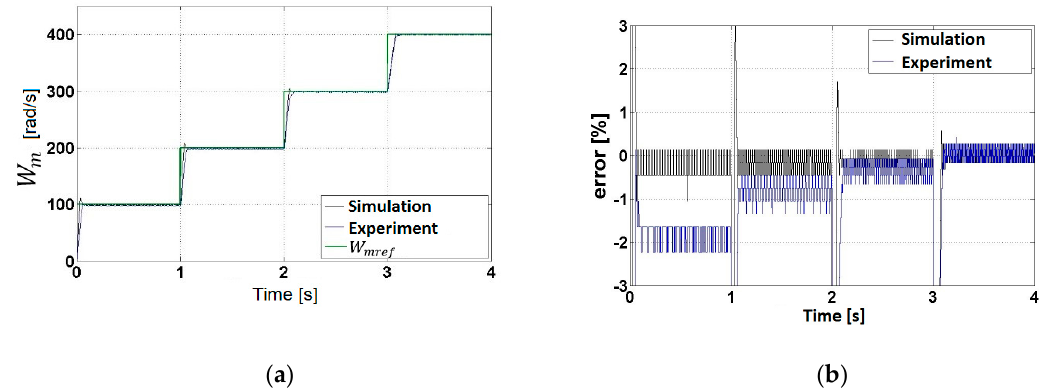
Figure 8. Numerical and experimental results in closed loops: ( a ) mechanical speed W m and reference speed W mref in a closed-loop system and ( b ) error of W m in a closed-loop system.